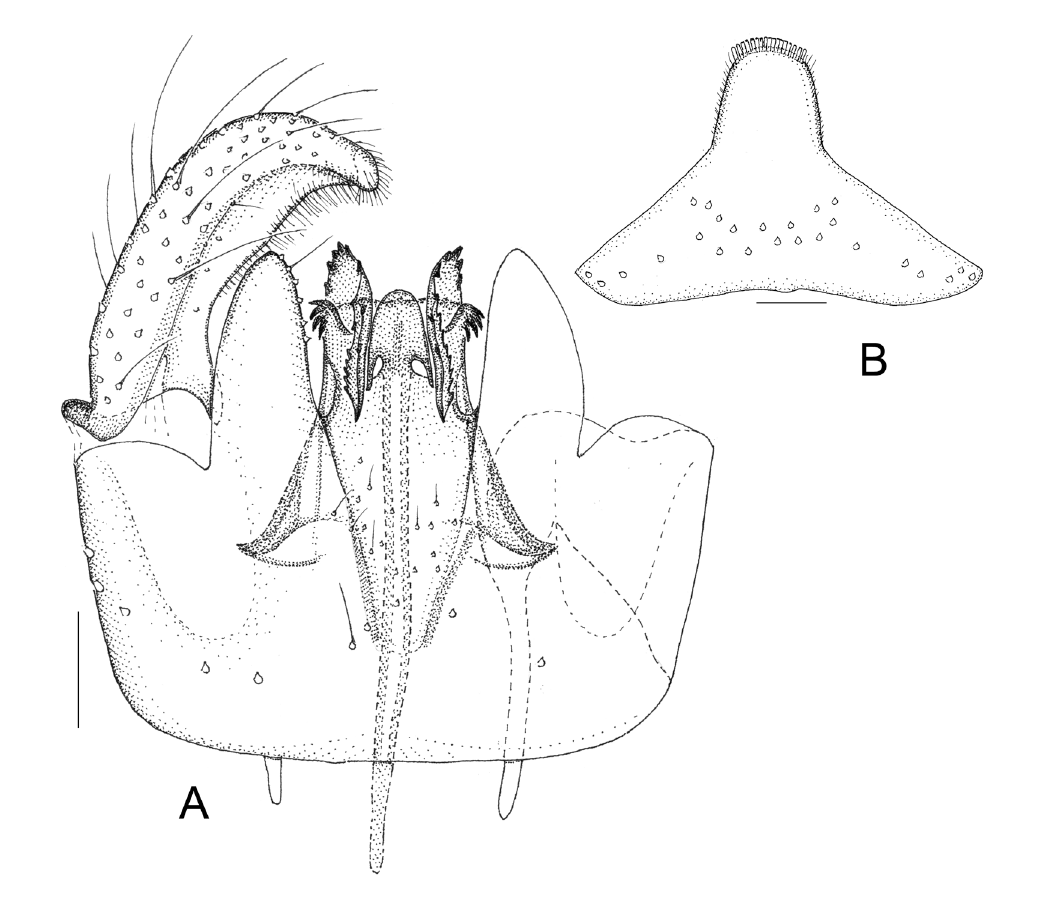
Fig. 19. Glemparon manuka sp. nov., holotype, ♂ (AM, no. CEC1409). A . Genitalia, ventral. B . Ninth tergite, dorsal. Scale bars = 0.05